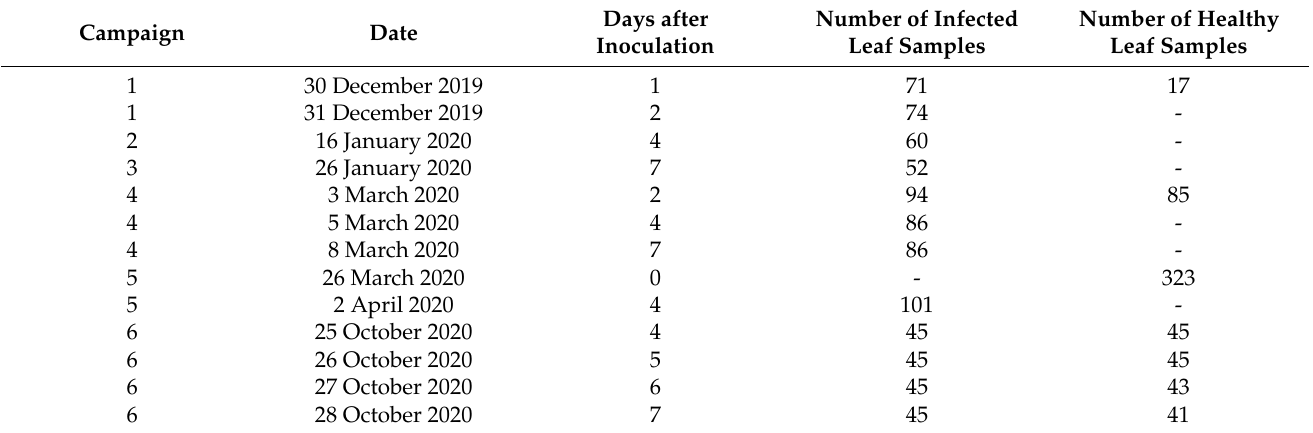
Table 1. The experimental schedule.